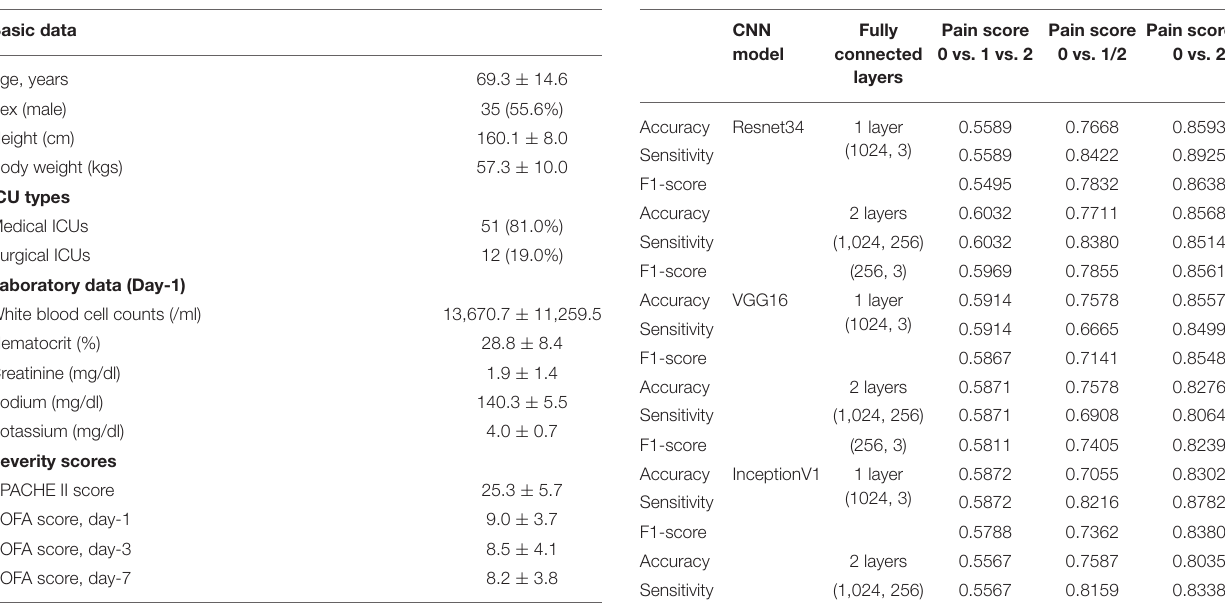
TABLE 2 | Performance image-based pain classifiers with pain score zero as the reference in different settings.